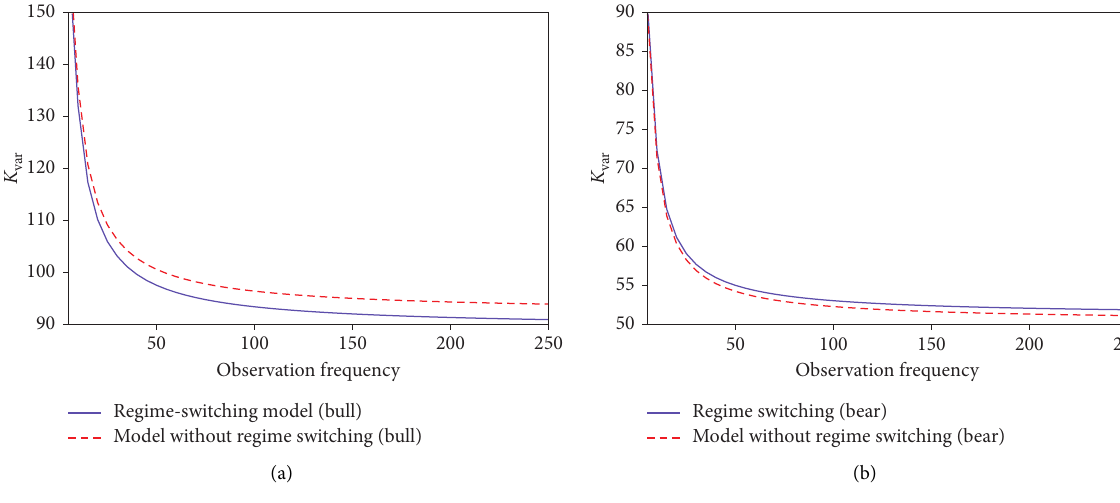
with and without regime switching with generator Q var